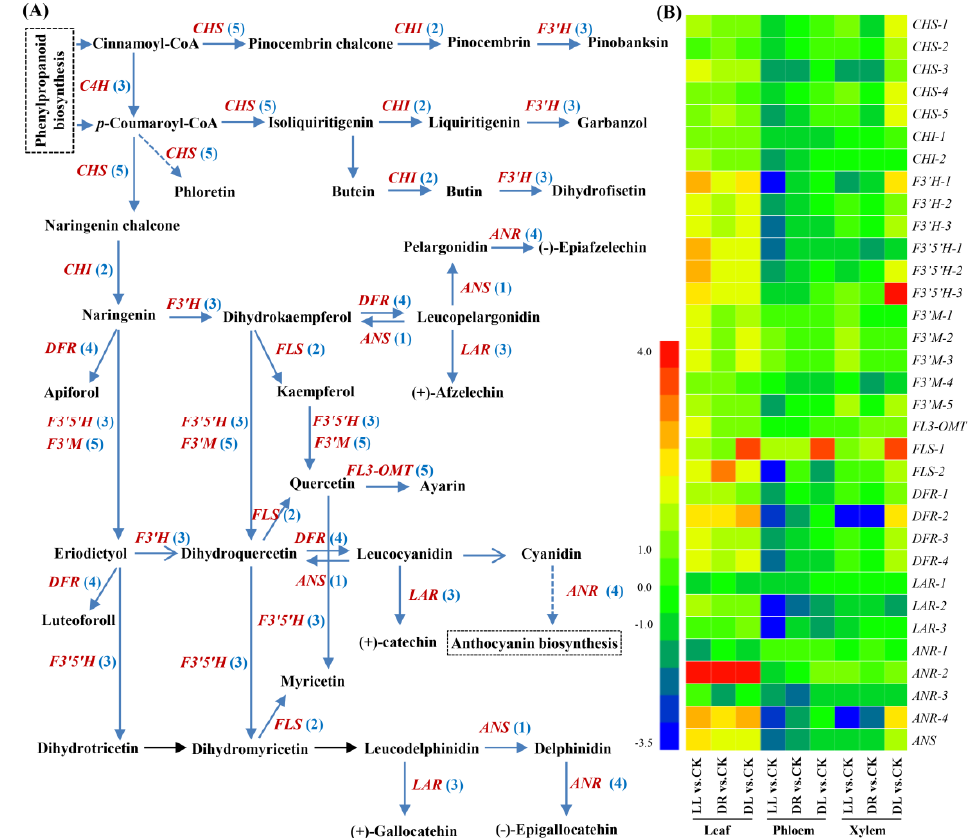
Figure 6. Expression patterns of low light, drought, and their combined stress on DEGs involved in flavonoid biosynthetic pathway: ( A ) the identified DEGs in flavonoid biosynthetic pathway and ( B ) expression patterns of DEGs in leaves, phloem, and xylem. CK: control; LL: low light; DR: drought; and DL (DR + LL): the combined stress of drought and low light. Detailed information is in Supplementary Table S8.